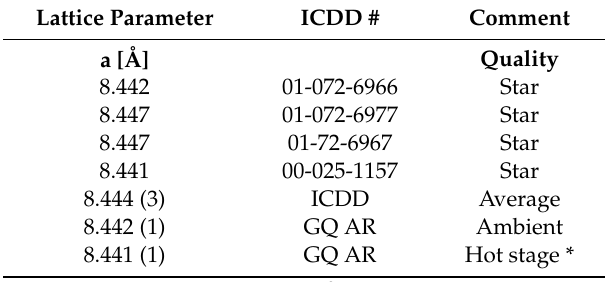
Table 2. Room temperature lattice parameters of Mg 2 TiO 4.